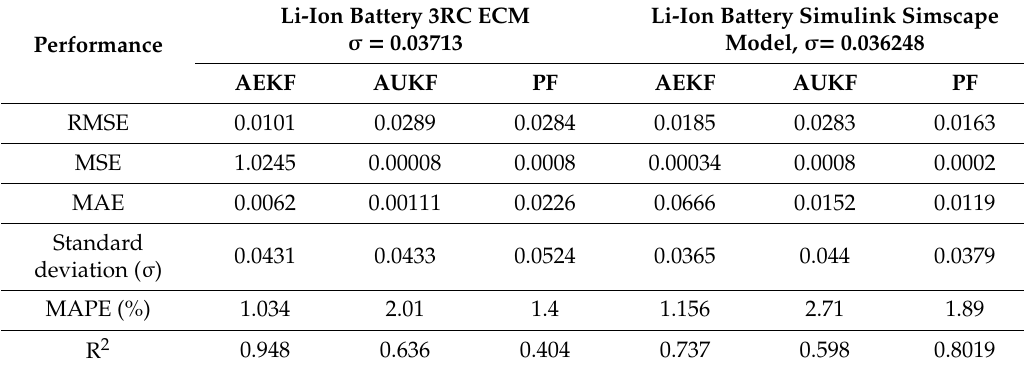
Table A1. Statistical errors—SOC estimates versus Li-ion battery Simscape model SOC values—Scenario R1 (SOCini = 0.4).